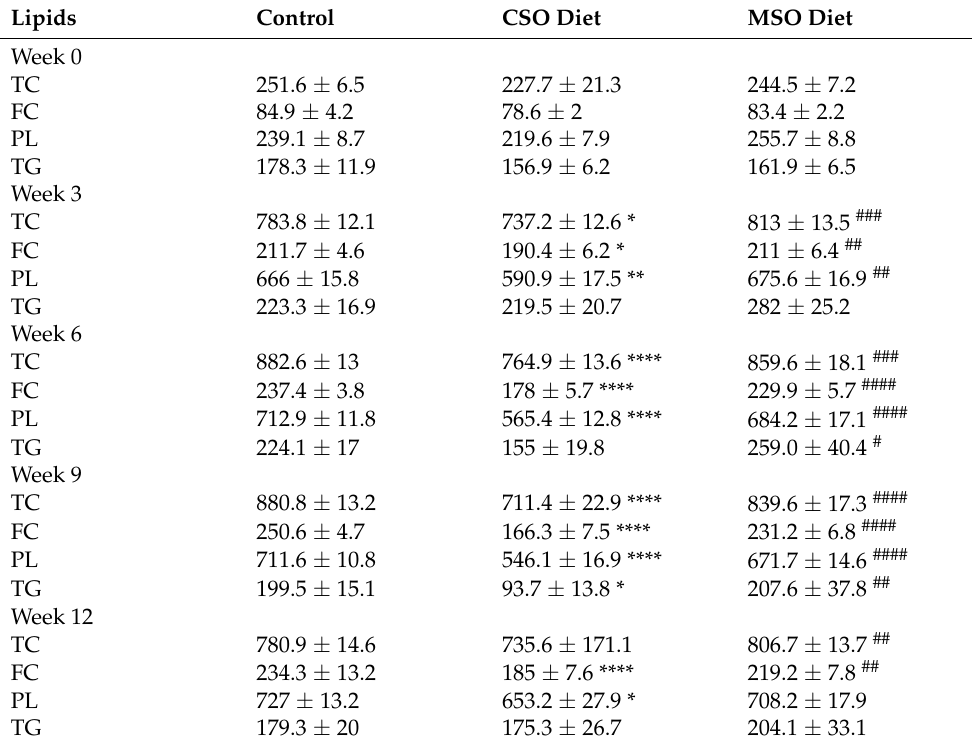
Table 2. Effect of CSO and MSO diets on plasma lipid levels in LDLR-KO mice.